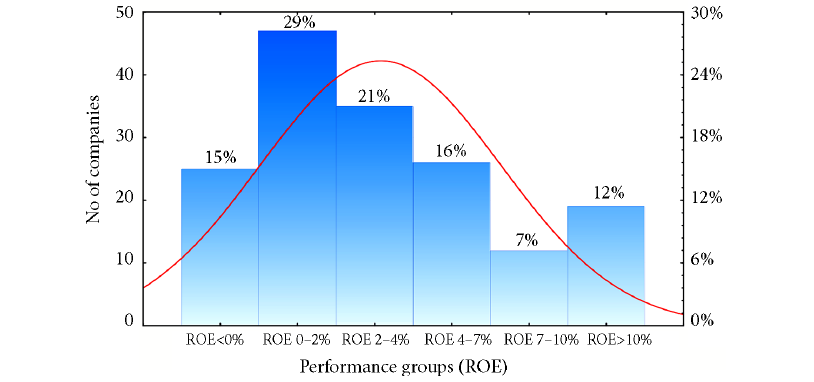
Figure 1. Histogram: business performance – ROE (source: